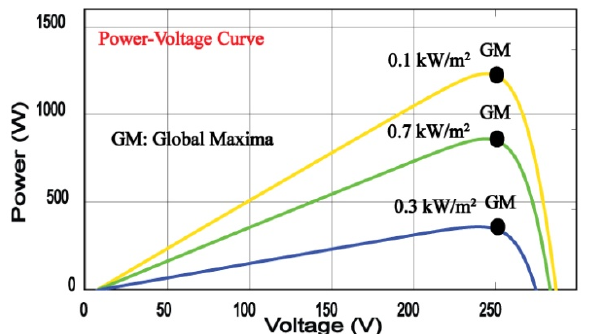
Figure 4. The voltage–power curve under UIC.